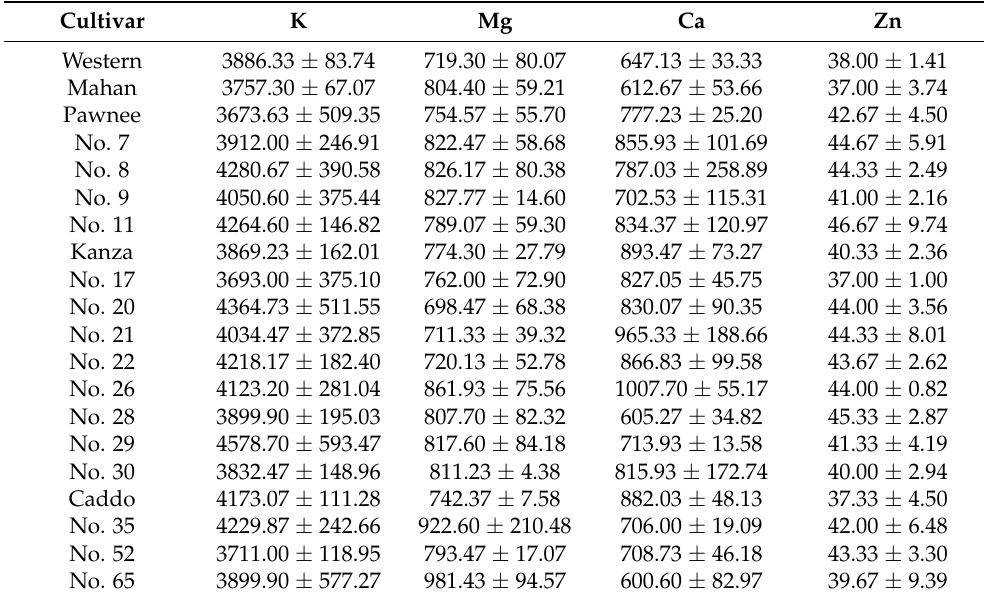
Table 4. Mineral composition (mg/kg) of the pecan